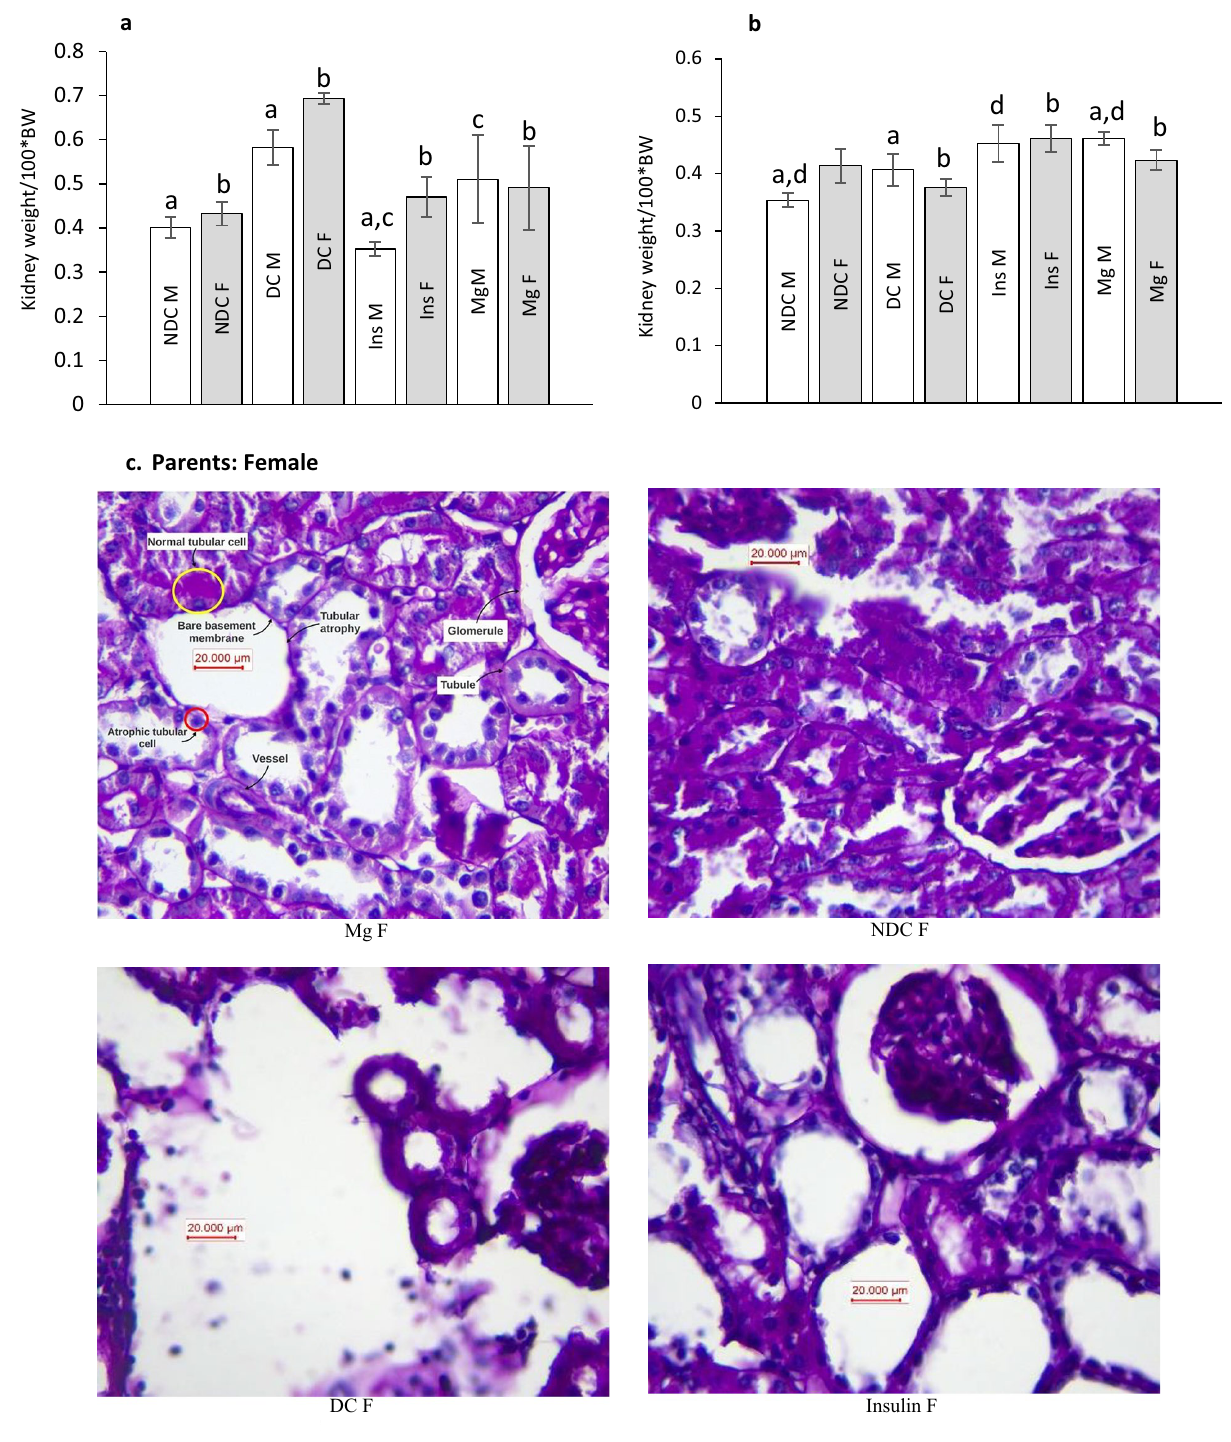
Figure 6. Comparison of kidney weight in male and female parents and their male and female offspring ( a and b respectively) and images of kidney tissues (Magnification × 100) in male and female parents and their male and female offspring ( c – f ) in non-diabetic control group (NDC) was fed with normal diet, diabetic group received high-fat diet and 35 mg/Kg STZ (D), diabetic animals treated with insulin (2.5 U/Kg two time per day) (Ins) and diabetic animals treated with 10 g/l magnesium sulfate via drinking water (Mg). 10 rats in each group and data are expressed as mean ± SEM. Kidneys in all groups were weighed using a standard scale by one person immediately after isolation. ( a ) Significant difference between D male group and other male groups ( P < 0.0001). ( b ) Significant difference between D female group and other female group ( P < 0.001). ( c ) Significant difference between male Mg group and male insulin group ( P < 0.001). ( d ) Significant difference between male NDC and male Mg and male insulin groups ( P <